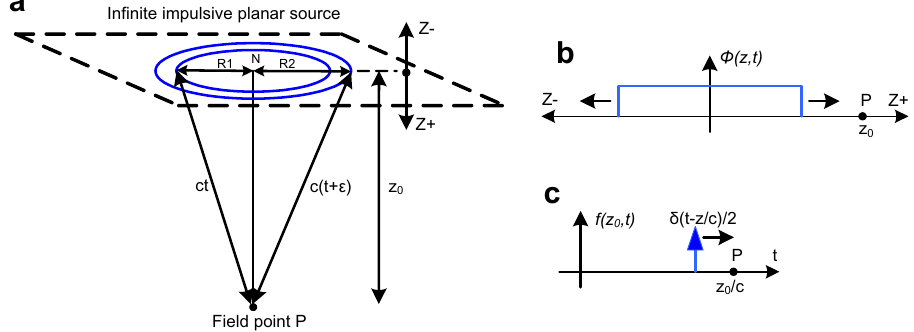
Figure 2. Planar source. ( a ) An infinite plane with impulsive excitation, δ f ( t ). The excitation duration or temporal pulse width is ε . The parameter z 0 is the distance from the plane to a point in space, P , at which the wave field will be observed as a function of time. The propagation speed is c , where c > 0. R 1 and R 2 are the radii of an annulus defined by the intersection of the plane with two spheres of radii ct and c [ t + ε ]. The point N is the nearest point on the plane to the field point P . Each point on the plane is a point source which radiates an impulsive spherical wavelet. ( b ) The wave field ϕ that is propagated from the plane. ( c ) The wave front f in the Z + direction that is derived from the wave field which will arrive at P at t = z 0